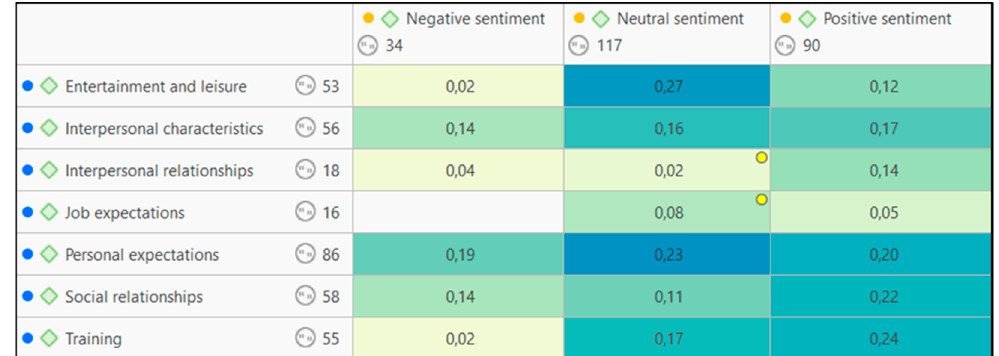
Figure 3. Table of co-occurrence between thematic codes that emerged in the analysis and codes of recognition of feeling.